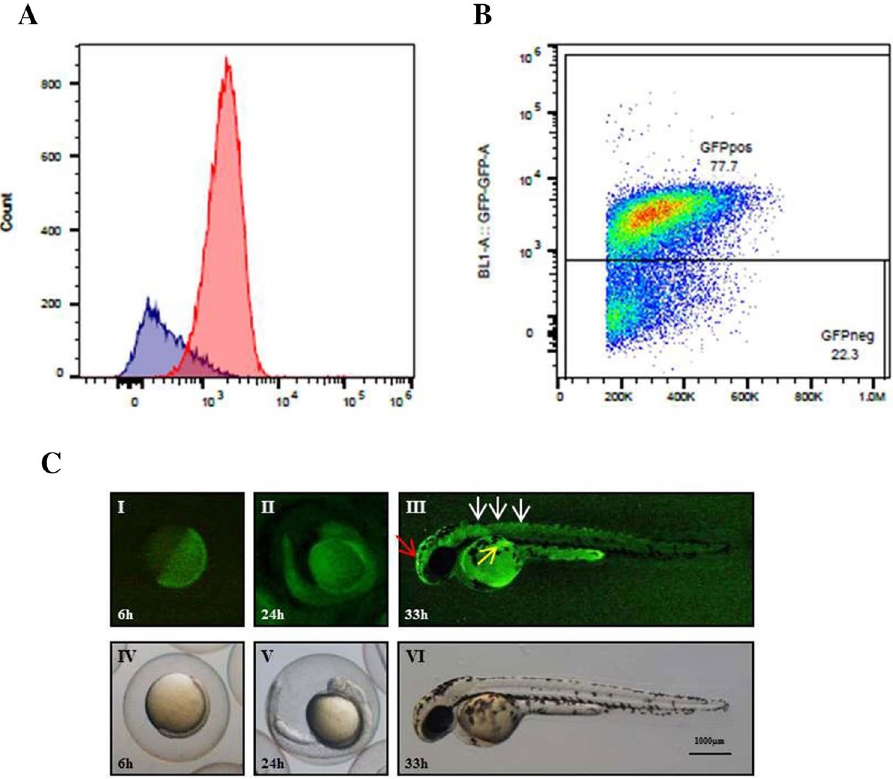
Figure 2. Fluorescence correlates with proliferation in MITO-Luc/GFP zebrafish line. ( A ) Flow cytometry analysis of cells dissociated from 200 zebrafish MITO-Luc/GFP 40 hpf embryos, previously incubated for 3 h with BrdU. Fixed cells were stained with anti-BrdU and anti-GFP antibodies. Histogram plot represents different BrdU accumulation in GFP positive (red) and negative (blue) cells. ( B ) GFP positive and GFP negative cells gating strategy. ( C ) GFP signal in 6 (I), 24 (II) and 33 hpf (III) embryos. GFP expression is almost ubiquitous throughout 6 and 24 hpf embryos (I,II). It is tissue specific in 33 hpf embryos being accumulated in the head (III, red arrow), proximal trunk (III, white arrows) and in developing fin (III, yellow arrow). Bright light images are shown